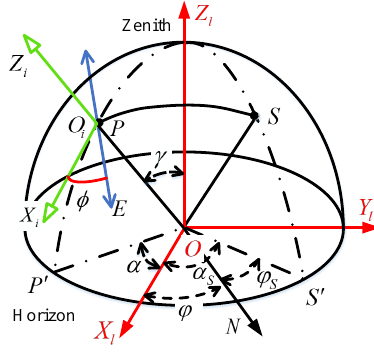
Figure 3. Description of the single scattering Rayleigh